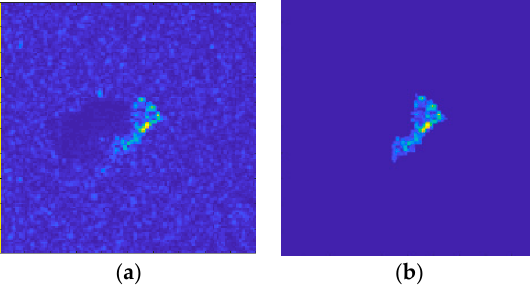
Figure 9. Illustration of target region segmentation: ( a ) original SAR image; ( b ) segmented image.